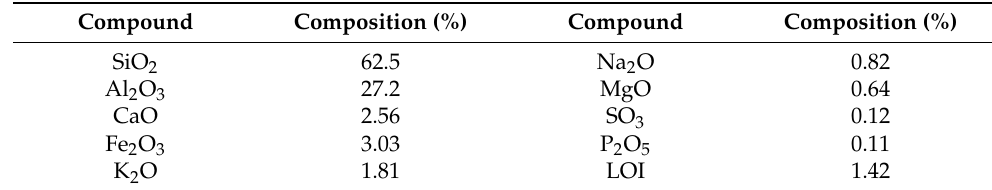
Table 1. Chemical composition of fly ash.